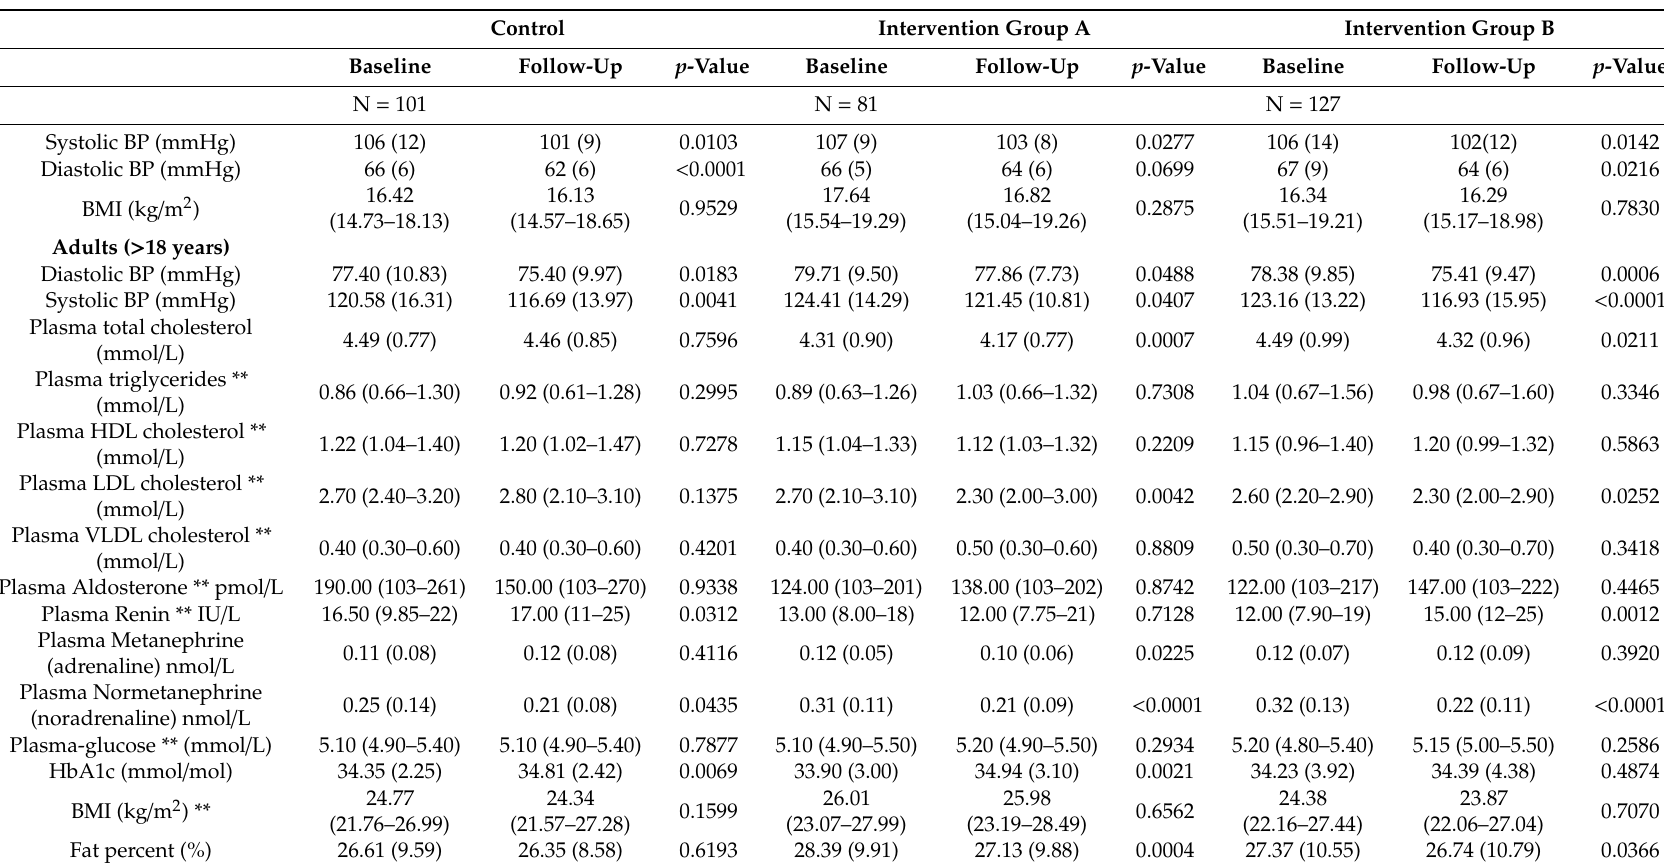
Table 2. Development in cardiovascular risk factors from baseline to follow-up in each group with p -value for change over time in each group.